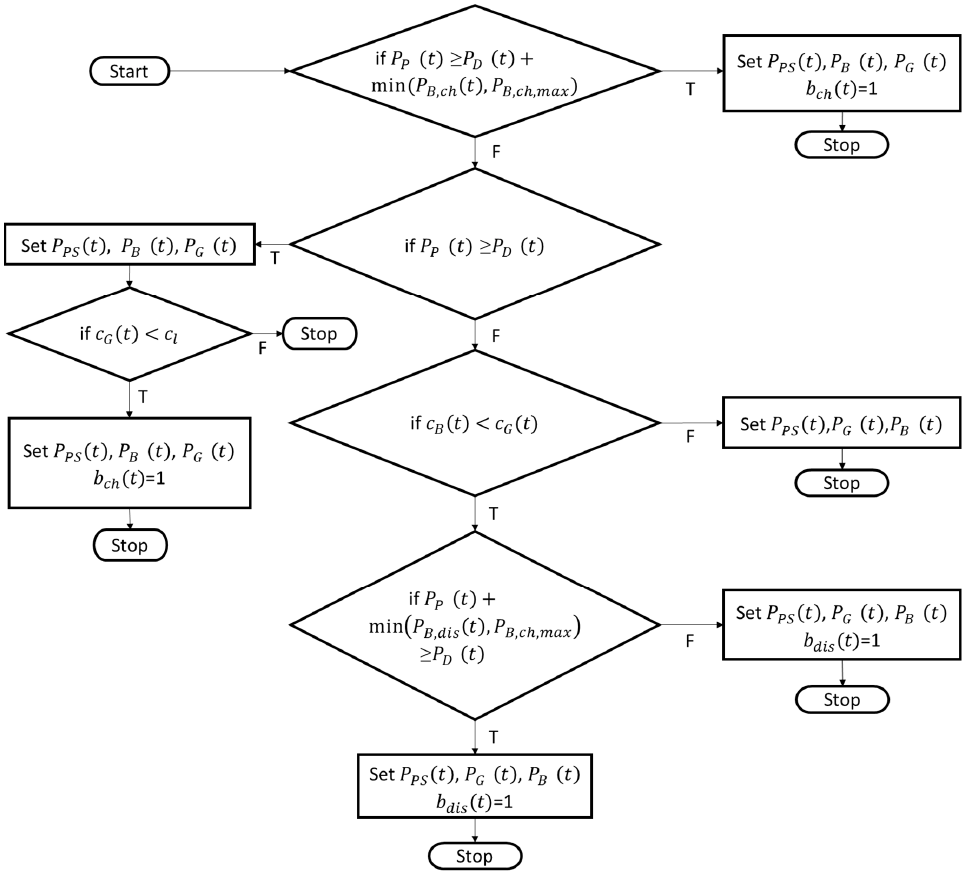
Figure 3. Simplified Logic Flow Diagram for Meeting Household Nanogrid Energy Demand.